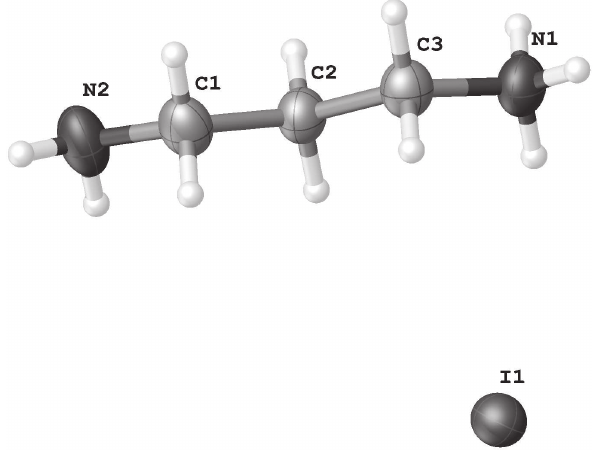
Table 1: Data collection and handling.